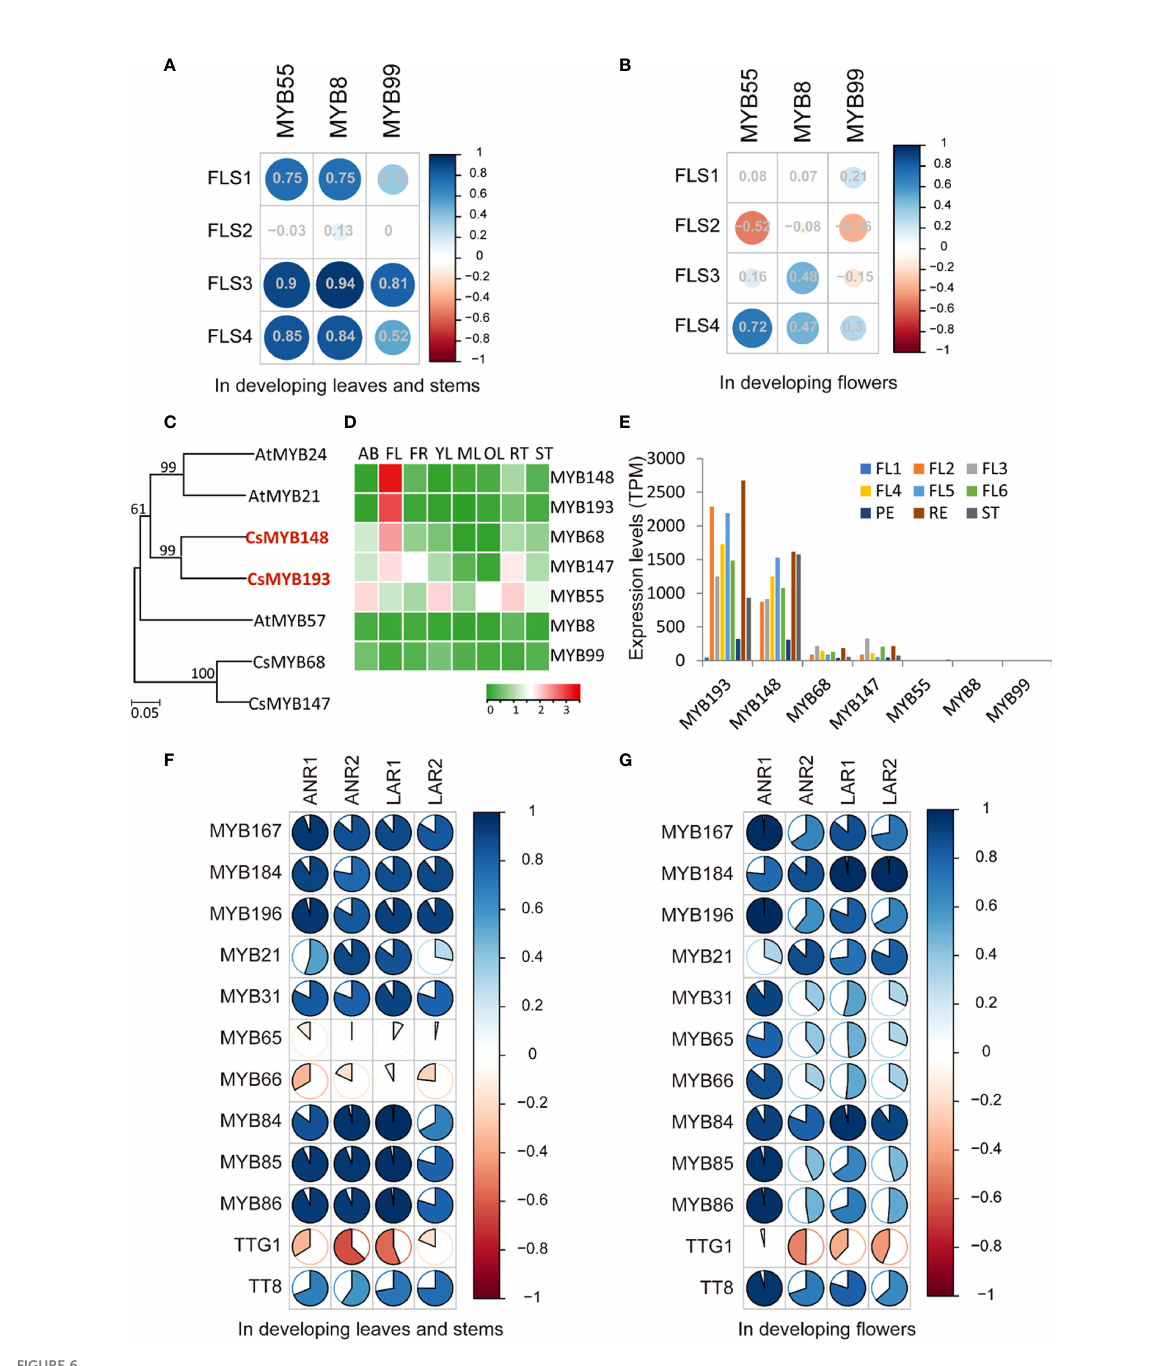
FIGURE 6 Transcriptional regulatory mechanism of fl avonol and catechin biosynthesis in tea fl owers. (A, B) Pearson correlation analysis of the expression of FLS genes and the expression of three fl avonol MYB regulator genes in developing leaves (A) and developing fl owers (B) . The sizes of circles indicate the degree of correlation. Green indicates a positive correlation, and red indicates a negative correlation. (C) Phylogenetic tree of tea MYBs with others related to fl avonol biosynthesis regulation in fl owers. The numbers at the nodes indicate the bootstrap value with 1,000 replicates. The red MYB genes highlight their corresponding homolog genes in tea plants. (D) Heat map expression analysis of candidate MYB genes in different tea tissues. AB, apical bud; FL, fl ower; FR, fruit; YL, young leaf; ML, mature leaf; OL, old leaf, RT, root, ST, stem. The expression level [log10(FPKM)] of each gene is shown in the heat map boxes. (E) Expression level analysis of candidate MYB genes regulating fl avonol biosynthesis in tea developing fl owers. (F, G) Pearson correlation analysis of the expression of ANR and LAR genes and the expression of catechin regulator genes in developing leaves (F) and developing fl owers (G)